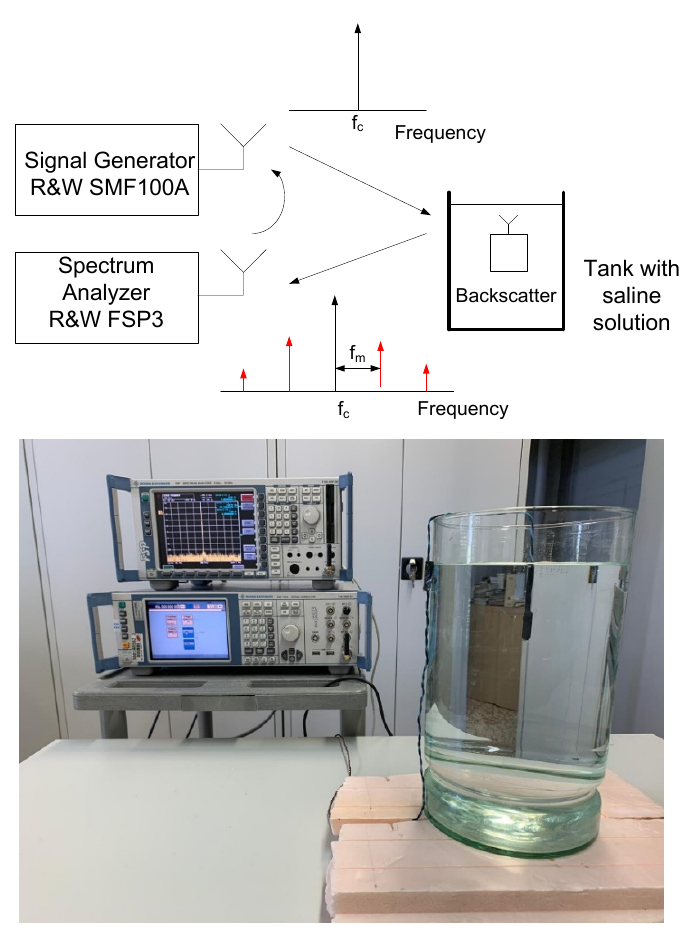
Figure 17. Block diagram of the setup used for the characterization of the backscatter and photograph (bottom).